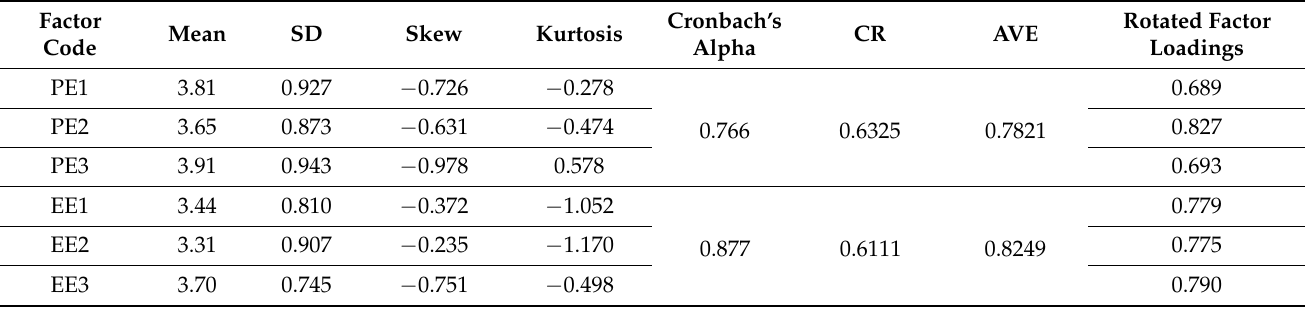
Table 2. Frequency of responses of the examined means, SDS, skewness, and